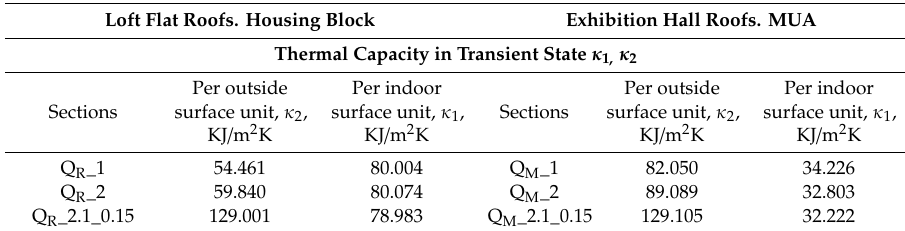
Table 9. Internal and external thermal capacity values κ 1, κ 2 .